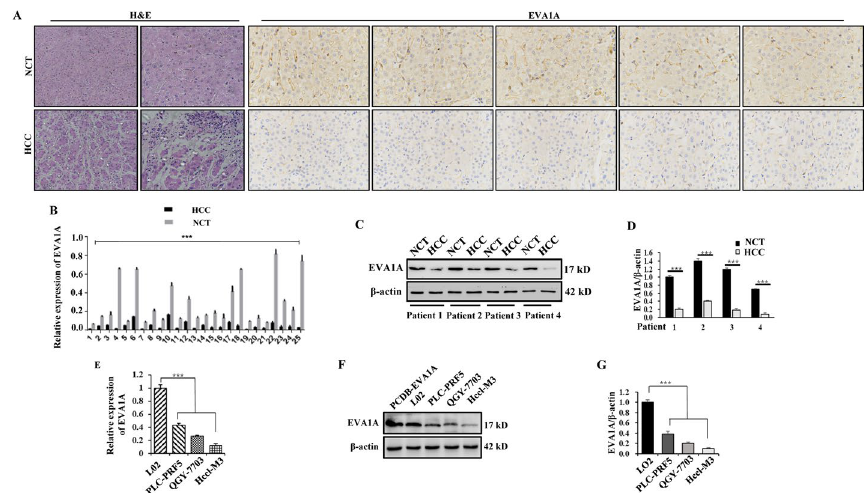
Fig. 1 EVA1A protein and mRNA levels in HCC tissues and HCC cell lines. A IHC staining of TMEM166 expression in HCC tissues and paired distant non-cancerous tissues (NCT) distinguished with H&E staining. B RT-qPCR analysis of EVA1A mRNA levels in twenty-five pairs of HCC and NCT samples. C , D Western blotting analysis of the expression levels of the EVA1A protein in HCC and NCT samples and quantitative analysis of the blot bands of EVA1A with ImageJ v1.53 k. β-actin was used as loading control. E , F , G RT-qPCR analysis of EVA1A mRNA levels ( E ) and western blotting analysis of EVA1A protein levels ( F , G ) in the normal human hepatocyte L02 cells and HCC cell lines. PCDB-EVA1A, an unlabeled plasmid, was used as a positive control. Data are presented as means SD of triplicate experiments. *** P < ±